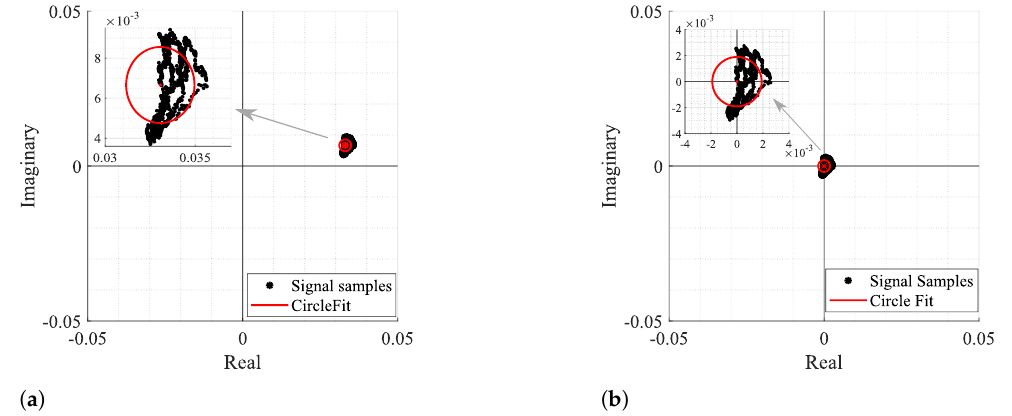
Figure 4. Example of how fitting methods can provide an inaccurate center estimation, when there is a lack of data resolution, with its zoomed version on the right: ( a ) Circle fitting result, ( b ) Arc disposition after removing the CDC